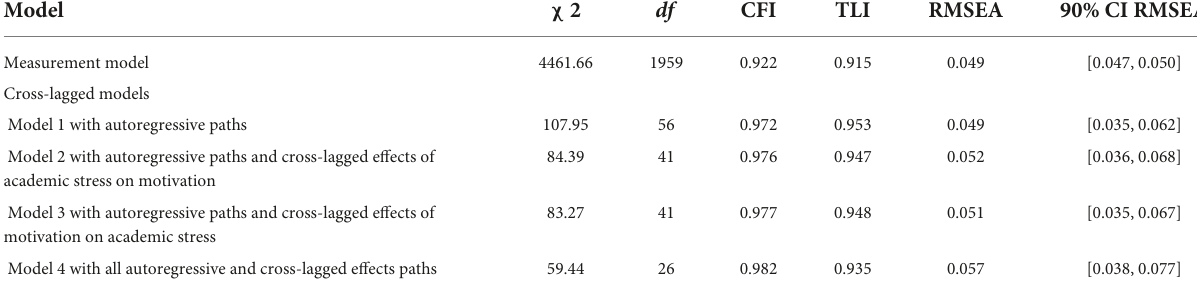
TABLE 1 Model fit